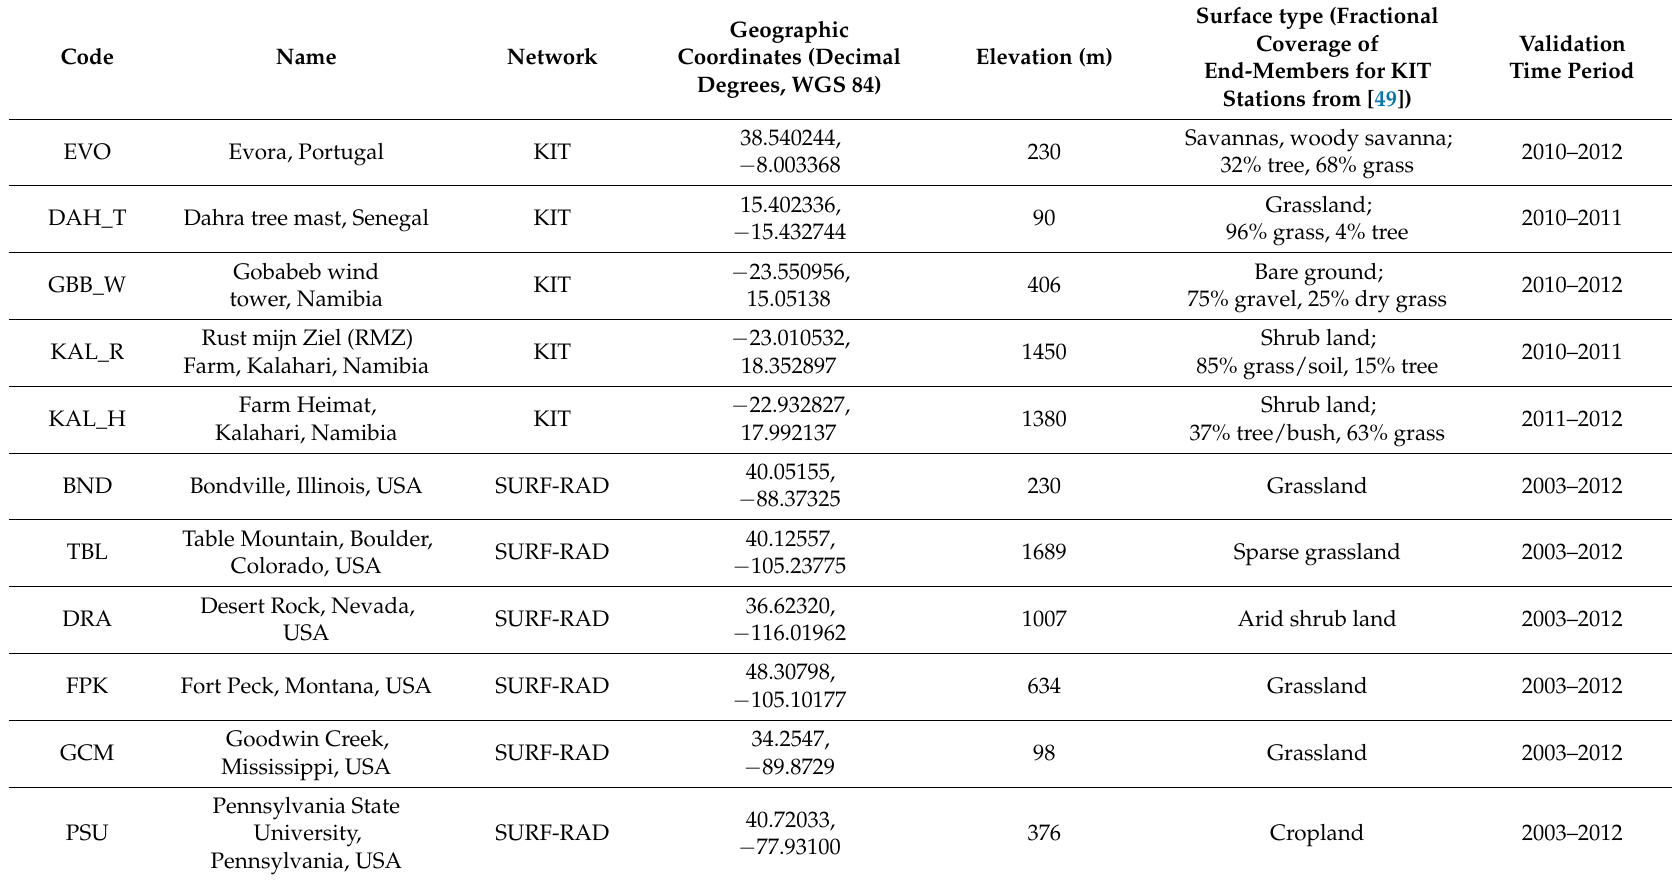
Table 2. Details on the in situ stations used for LST validation.